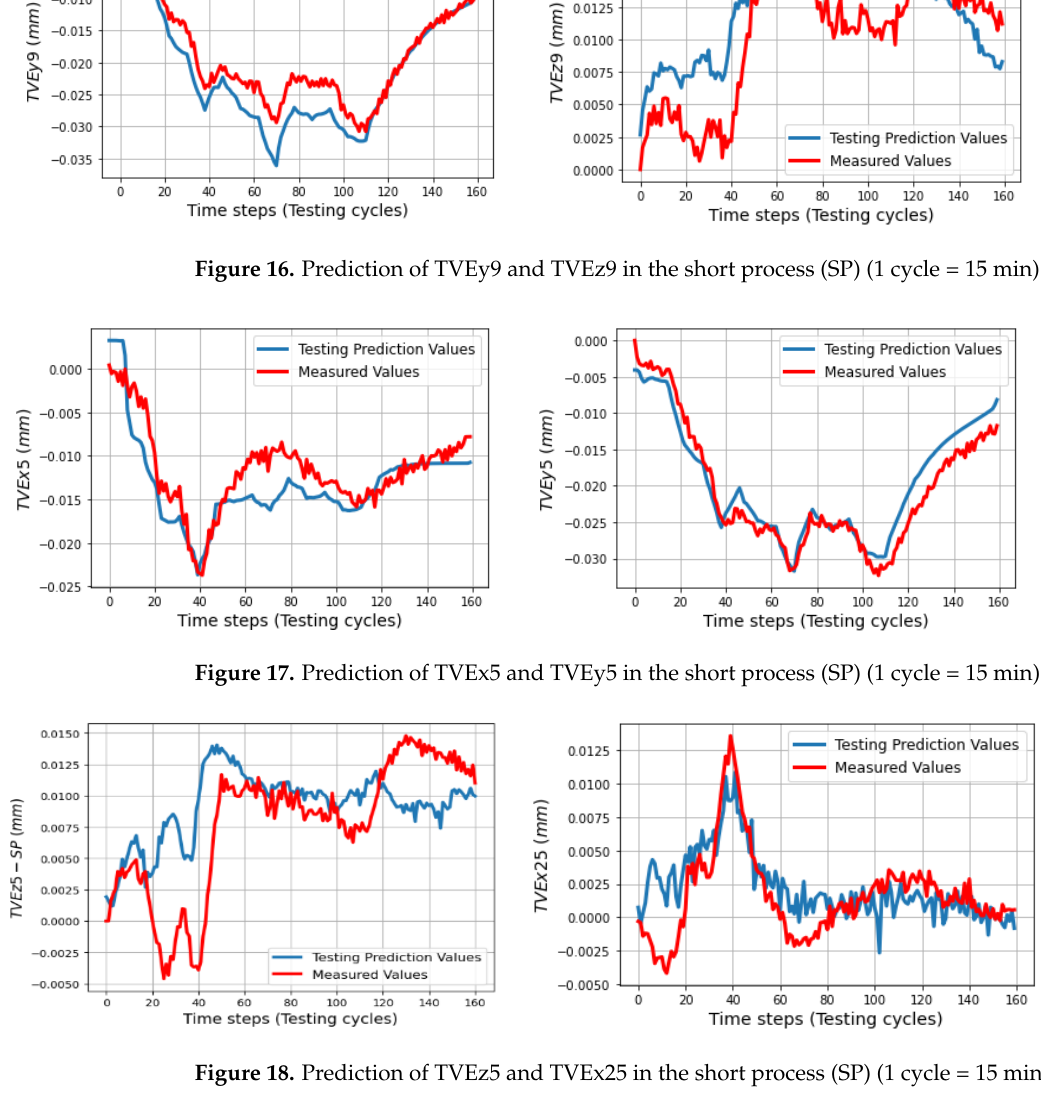
Figure 18. Prediction of TVEz5 and TVEx25 in the short process (SP) (1 cycle = 15 min) .